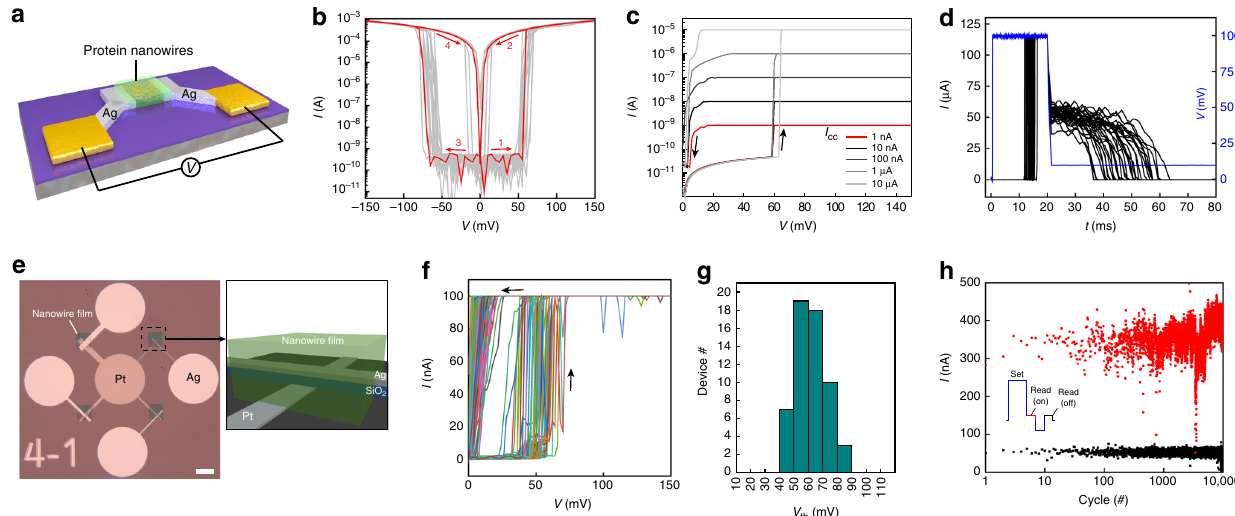
Fig. 2 Protein-nanowire devices and memristive switching. a Schematic of the planar device structure. b Representative I-V curves from a device. The red curves show a complete sweep loop from 0 → 150 mV → 0 → -150 mV → 0. c Switching I – V curves from a device with the current compliance ( I CC ) set from 10 µ A to 1 nA. d Pulsed measurements in a device ( N = 32). Same pulses (100 mV, 20 ms; blue curve) were applied to the device with the current (black curves) measured. The conduction state in the device was continuously monitored after the pulse by using a 10 mV reading voltage. e Photo image of 4 vertical protein-nanowire devices with varying sizes of 20 × 20, 10 × 10, 5 × 5, and 2 × 2 µ m 2 . Scale bar 50 µ m. The schematic shows the layered Ag – SiO 2 – Pt (100 – 25 – 30 nm thick) device structure embedded in patterned protein-nanowire fi lm (~500 nm thick). f A continuous 800 I – V sweeps in a vertical protein-nanowire device. Above measurements were done in the ambient environment with RH~35%. g Statistics of the turn-on voltage from 57 vertical devices, with an average value of 58 ± 10 mV (± s.d.). h A 10 4 cycles from a vertical device. Each cycle involved a pulse wave form (inset) consisting of a programming (set) pulse (100 mV, 40 ms), a read pulse (10 mV, 19 ms) of the On current, a reset pulse ( − 50 mV, 20 ms) to facilitate the relaxation, and a read pulse (10 mV, 19 ms) of the Off current. Current compliance was applied to the On read current with a load resistor. The Off read current was at the instrument noise level (<100 nA) for the measurement range